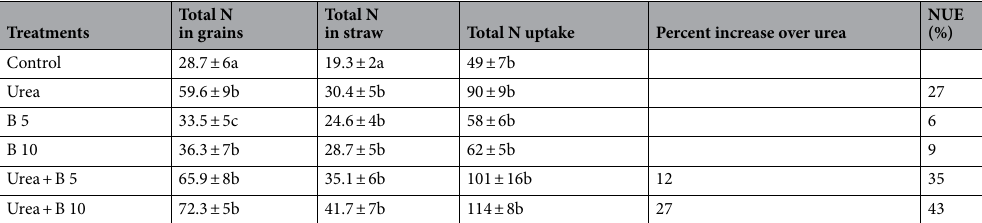
Table 4. Grains, straw, and total N uptake (kg ha -1 ), and NUE (kg N uptake kg −1 of applied N) in soils amended with sole urea or urea + biochar treatments. Values within a column followed by the same letter are not-significantly different at P < 0.05.